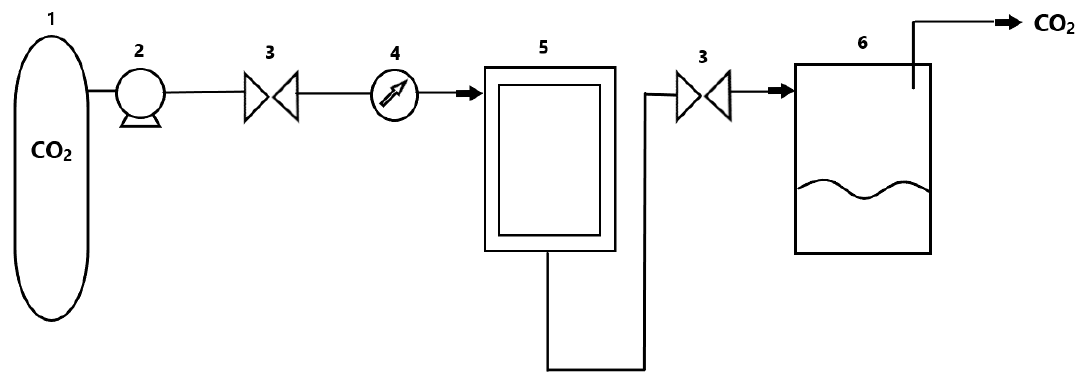
Figure 2. A simplified diagram of the installation for fluids extraction in supercritical conditions. (1) CO 2 tank; (2) pump; (3) valve; (4) temperature control system; (5) extractor; (6) separator.